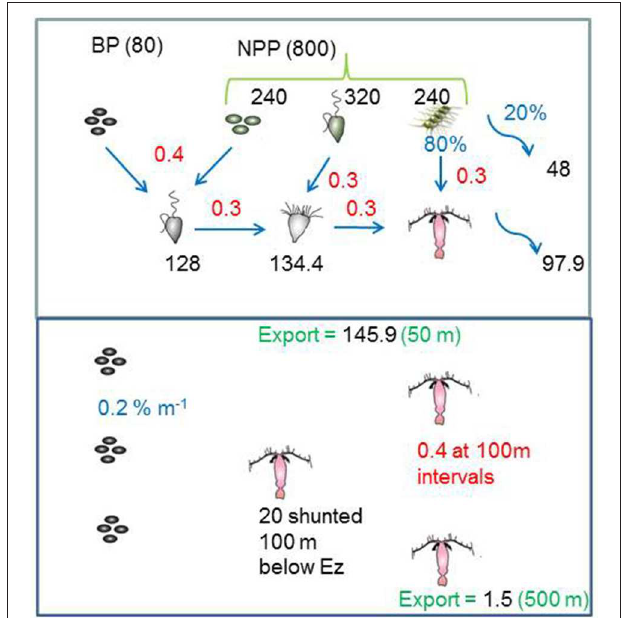
FIGURE 2 | The model standard run for the high latitude ocean case, that illustrates how the inputted POC in the Ez is transformed by trophic transfers (using published data from Table 1). In the subsurface ocean the export flux is further attenuated by continuous (microbes) and discrete (zooplankton) transformations, and supplemented by a shunt of POC to one discrete depth from vertical migrators. Black text denotes fluxes (mg C m − 2 d − 1 ), red are trophic transfer efficiencies (proportion of 1), and blue represents (%) such as the partitioning of micro-phytoplankton NPP between grazing and direct